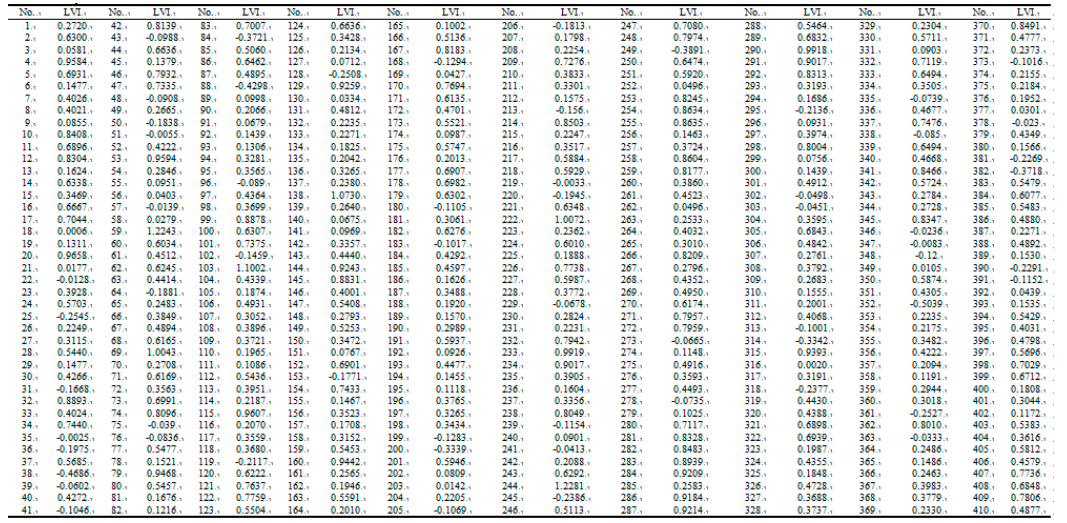
Figure A2. All livelihood vulnerability indices of the sample.